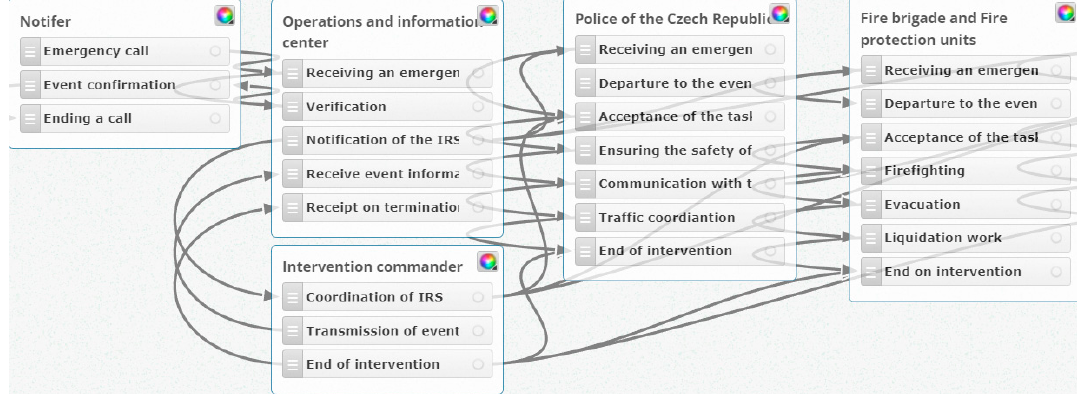
Figure 3. Scenario creation and graphical display of exercises.